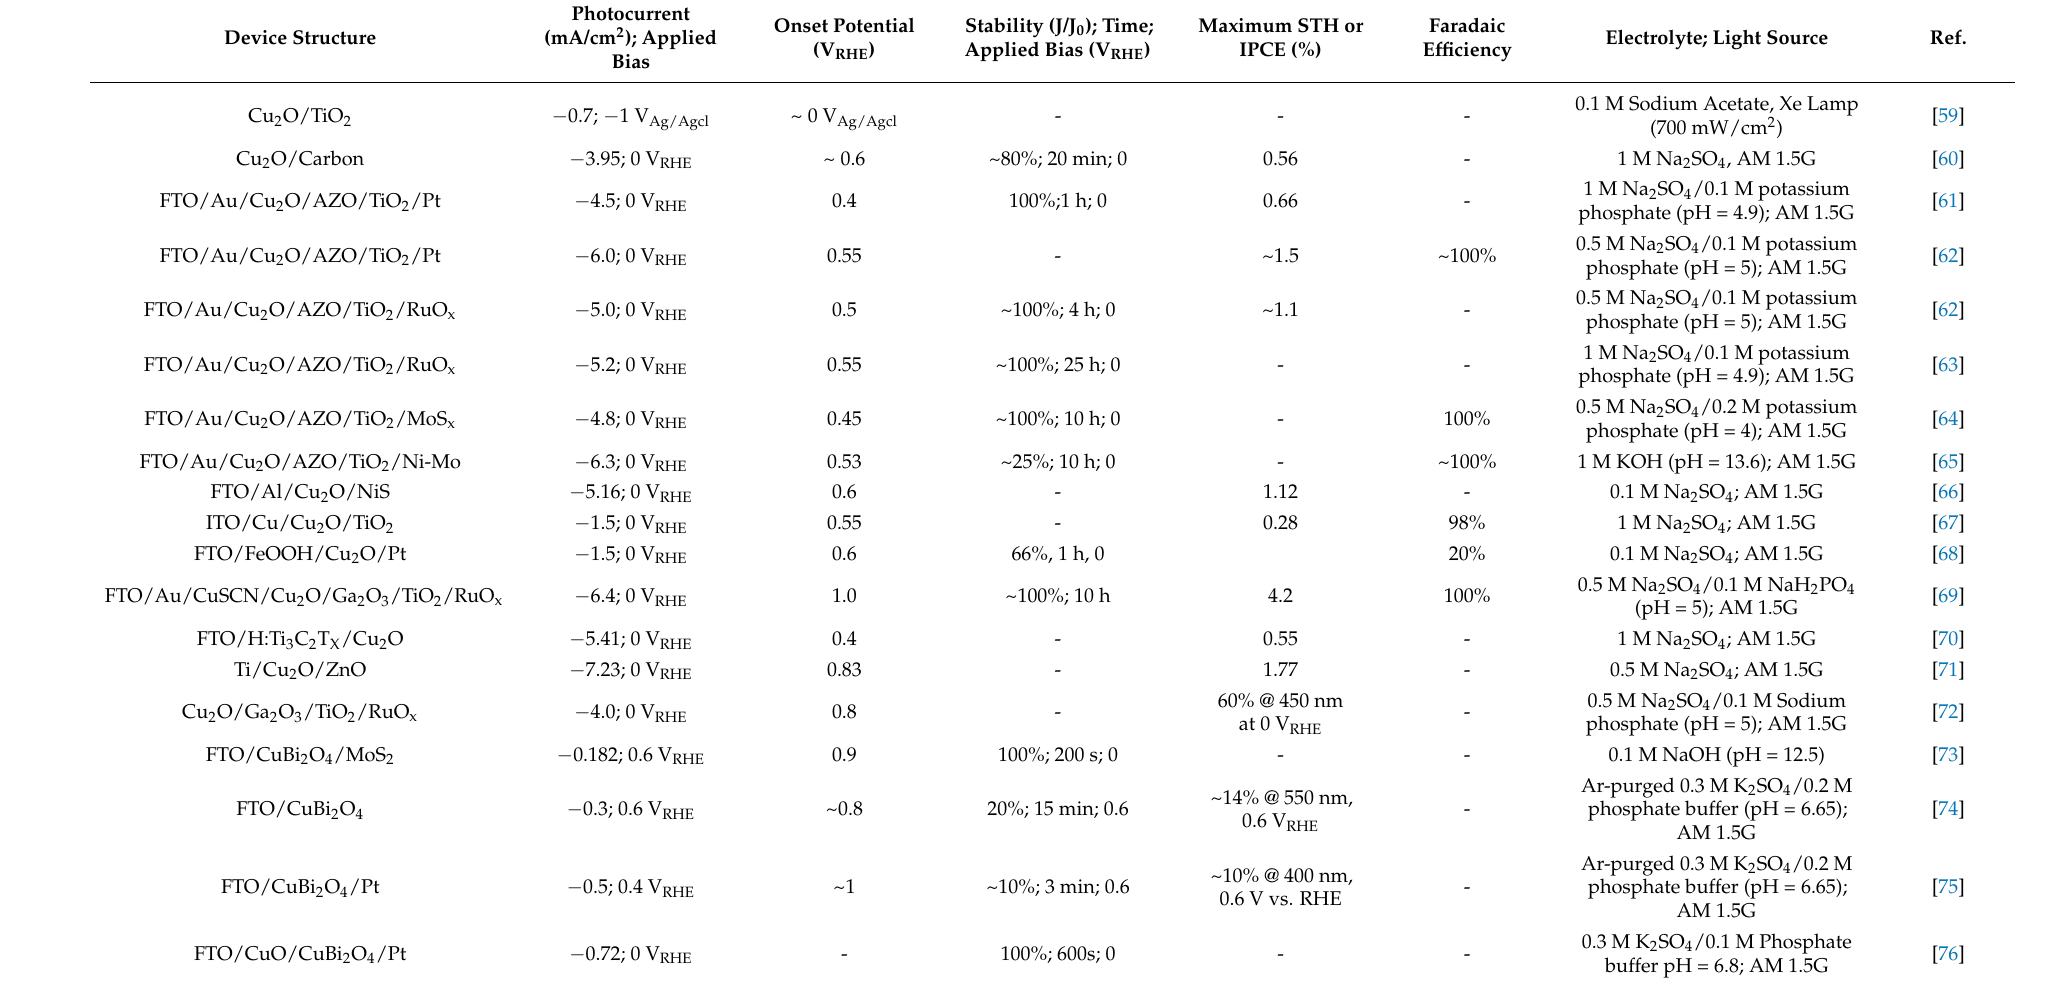
Table 1. Photoelectrochemical performances of the Cu-based metal oxide photocathodes.